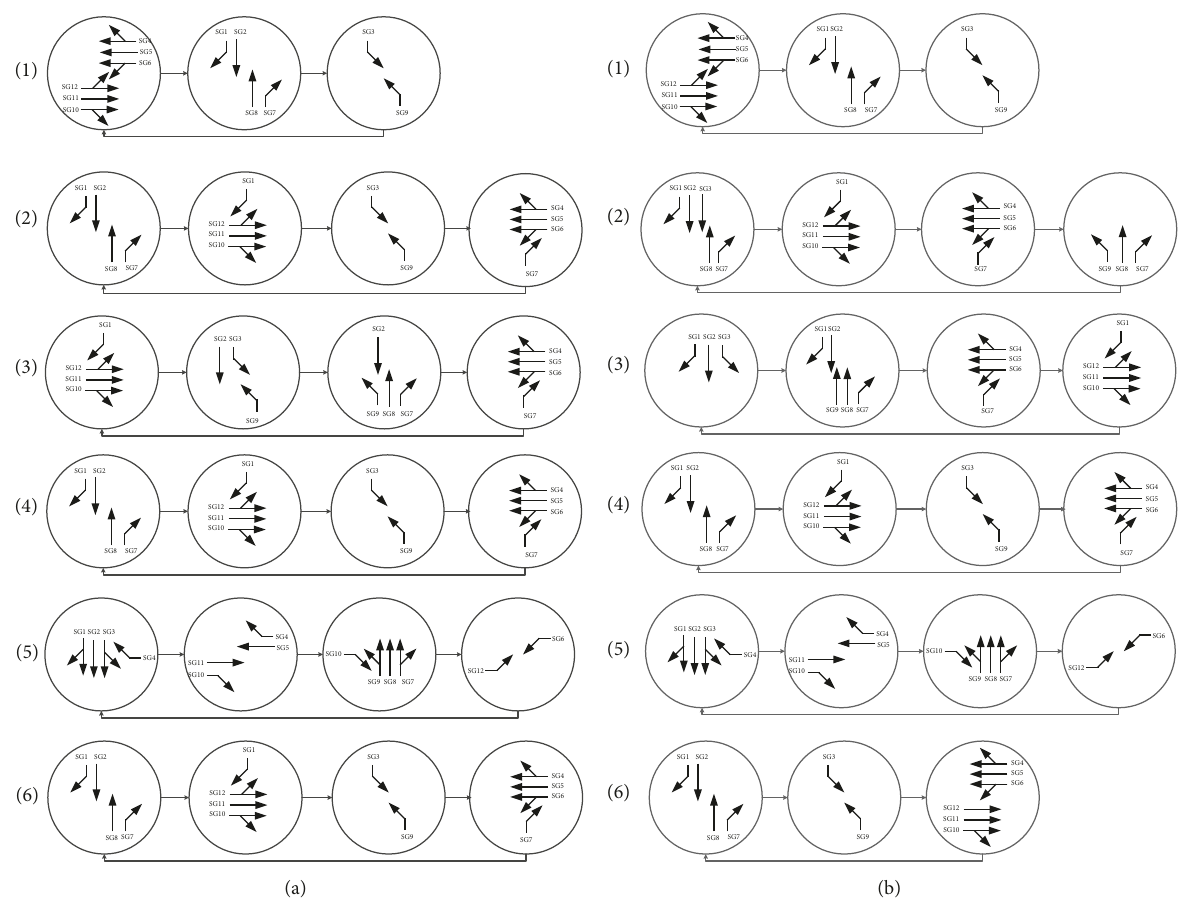
Figure 8: (a) Generated stages of test network and their sequence before LTP; (b) generated stages of test network and their sequence after LTP.